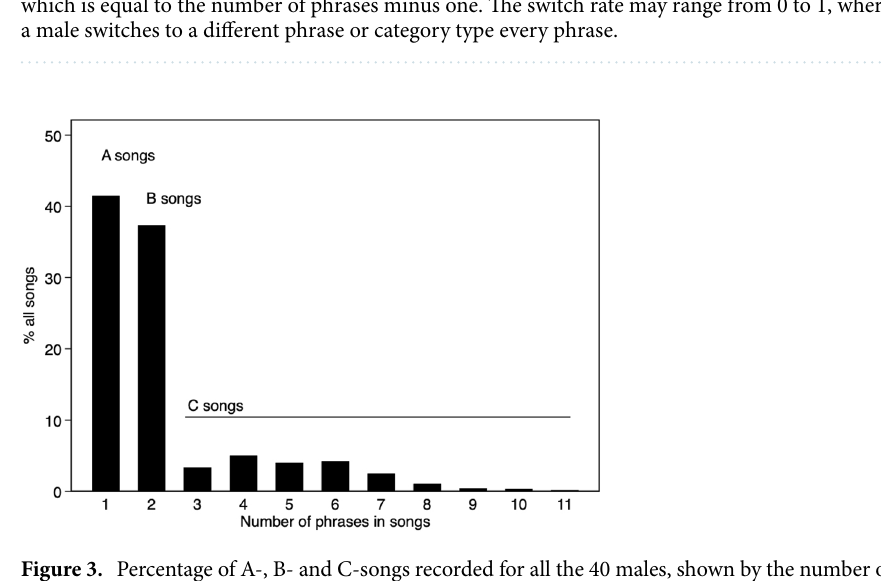
Figure 3. Percentage of A-, B- and C-songs recorded for all the 40 males, shown by the number of phrases per